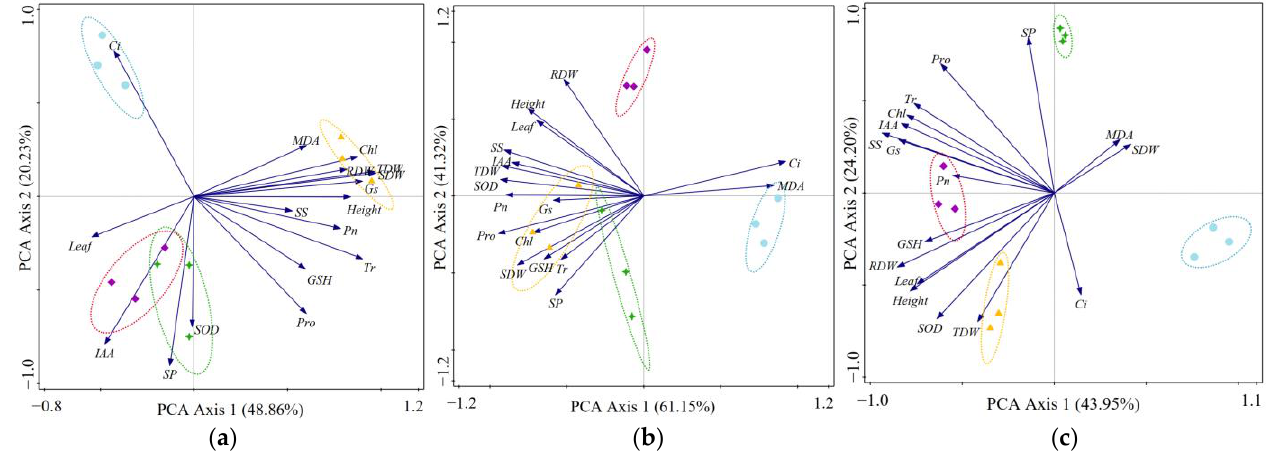
Figure 5. The influences of the DSE treatment on the performance of wheat under three levels of water treatment based on principal component analysis. a,b,c represent principal component anal- ysis of the DSE’s influence on the fitness of wheat seedlings under WW ( a ), MD ( b ), and ED ( c ), respectively. Leaf, leaf number. Height, plant height. GSH, glutathione content. SOD, superoxide dismutase. MDA, malondialdehyde content. SS, soluble sugar content. SP, content of soluble pro- tein. Pro, proline contents. Gs , stomatal conductance. Pn , photosynthetic rate. Ci , intercellular CO 2 concentration. Tr , transpiration rate. SDW, shoot biomass. RDW, root biomass. TDW, total biomass. ○ , ◇ ,  , and △ indicate CK, Aa, Pp, and Pr ,